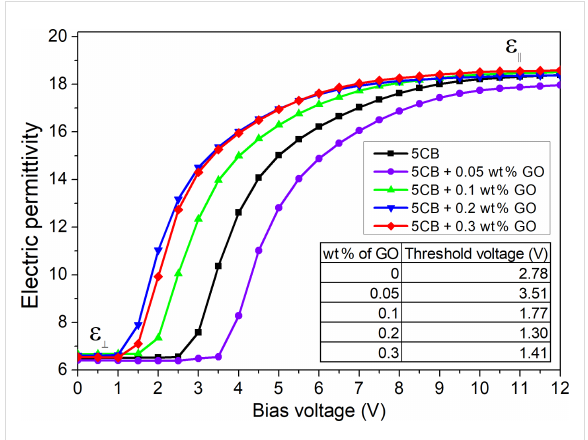
Figure 6: Electric permittivity ε dependence upon the bias (dc) electric field at a frequency of 1 kHz. Results obtained for the pure 5CB and the 5CB-GO suspensions at different concentrations. The inset shows the threshold voltage U th-DS dependence of the GO concentration. Ex- perimental data is presented as scattered points with the line as a guide for the eye.